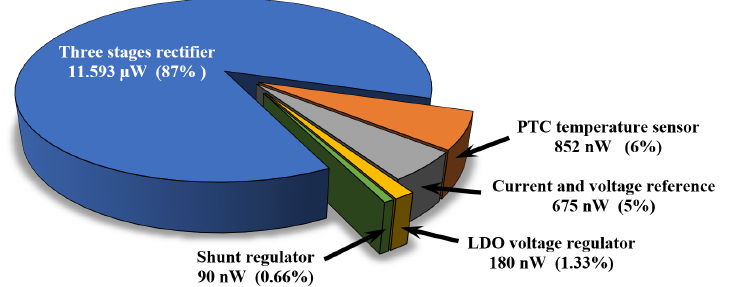
Figure 35. Distribution of the power consumption of each of the subcircuits that compose the proposed sensor